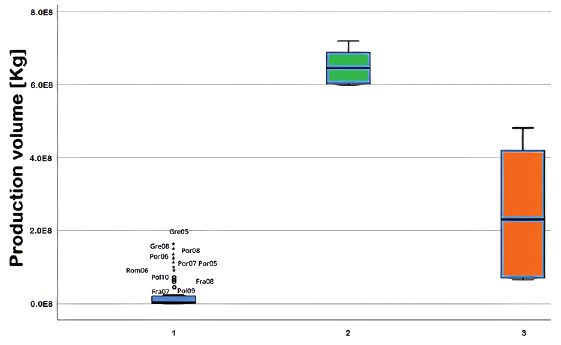
Figure 3. Box diagram of the pre-crisis production variable according to the clusters of the first two-stage clustering level (source: own elaboration)